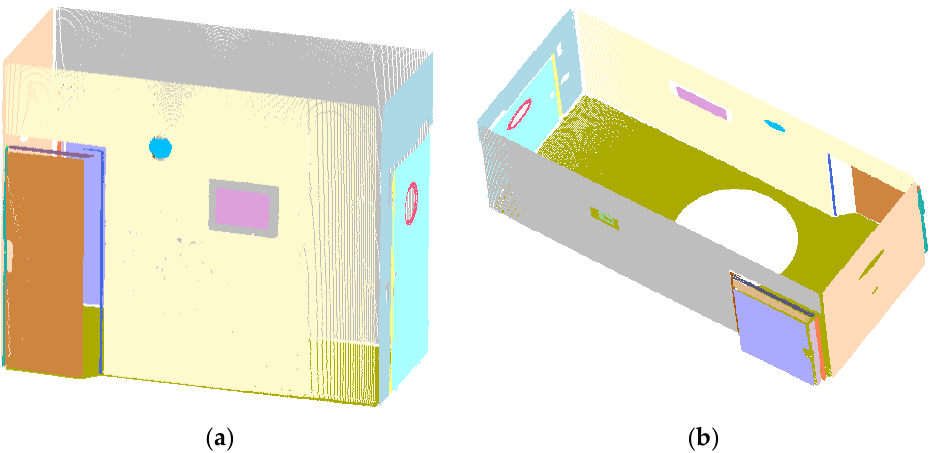
Figure 11. Cottage’s segmentation results using the region growing algorithm: ( a ) front view and ( b ) top view.